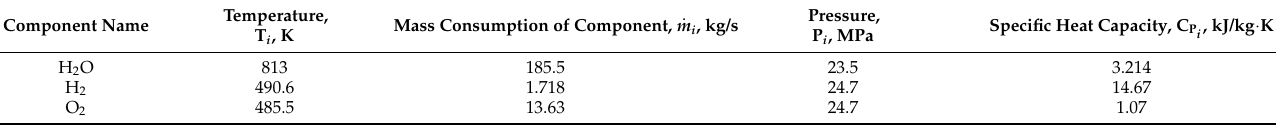
Table 3. Basic parameters for calculation.